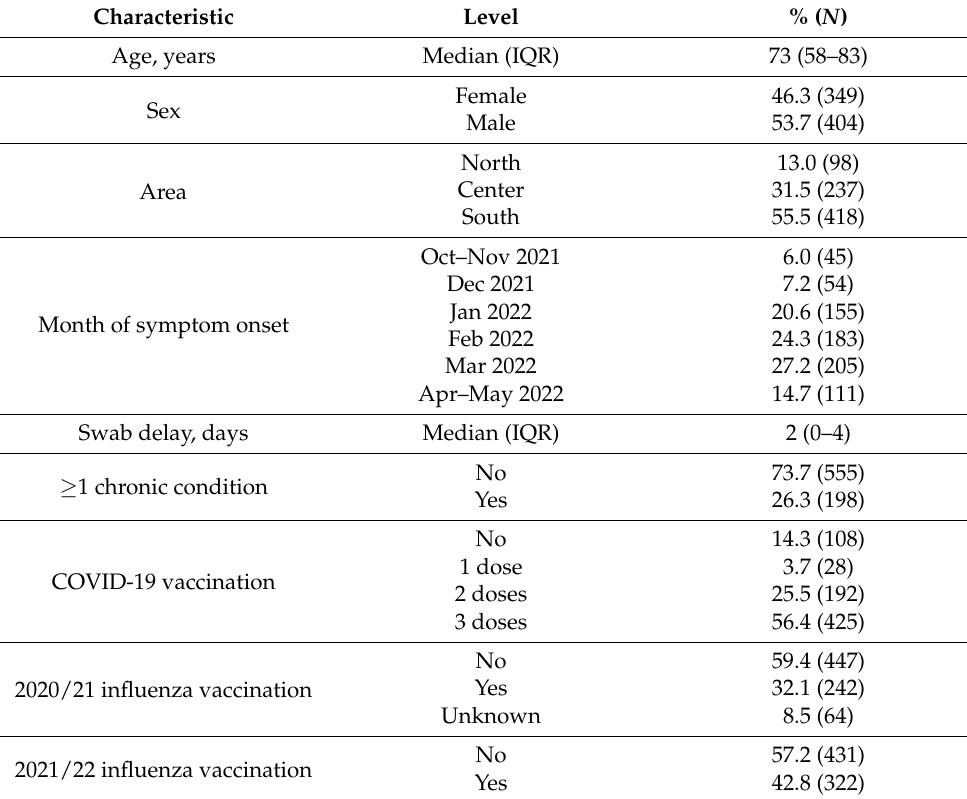
Table 1. Characteristics of the study participants ( N =